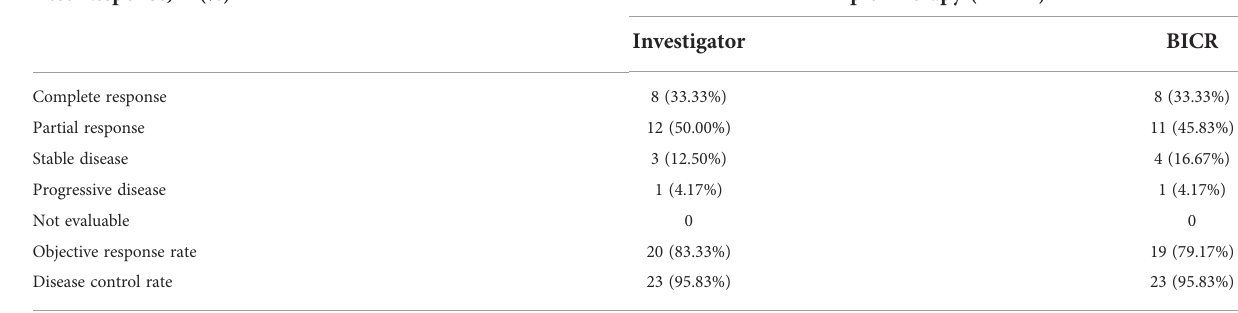
TABLE 3 Tumor Responses per Investigator and BICR Assessment. Best Response, n